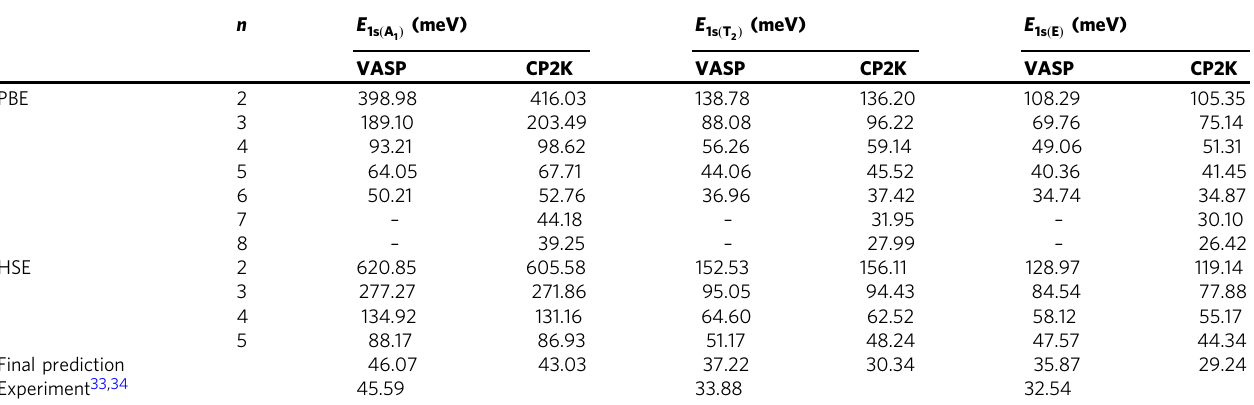
Table 1 Calculated binding energies of ground state E Perdew – Burke – Ernzerhof (PBE) and Heyd, Scuseria, and Ernzerhof (HSE) functionals.